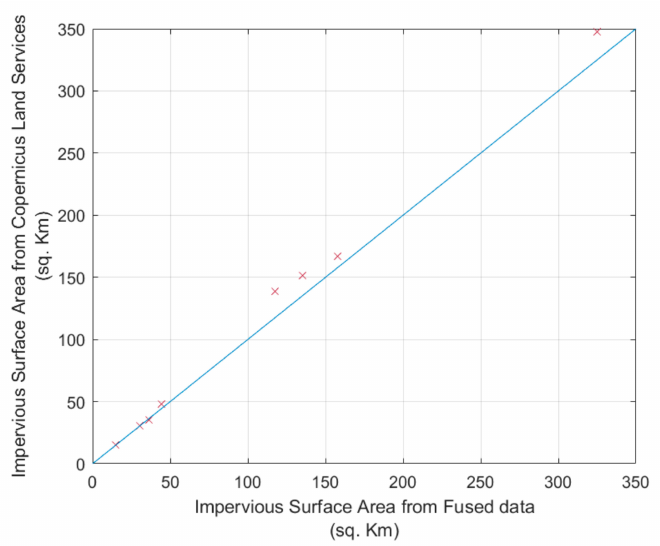
Figure 4. Correlation plot of impervious surface area from Copernicus Global Land Service ( y -axis) and this study ( x -axis).